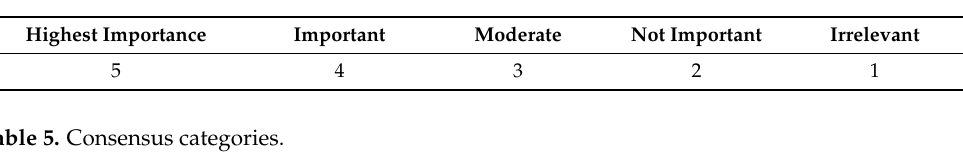
Table 4. Likert scale weights.